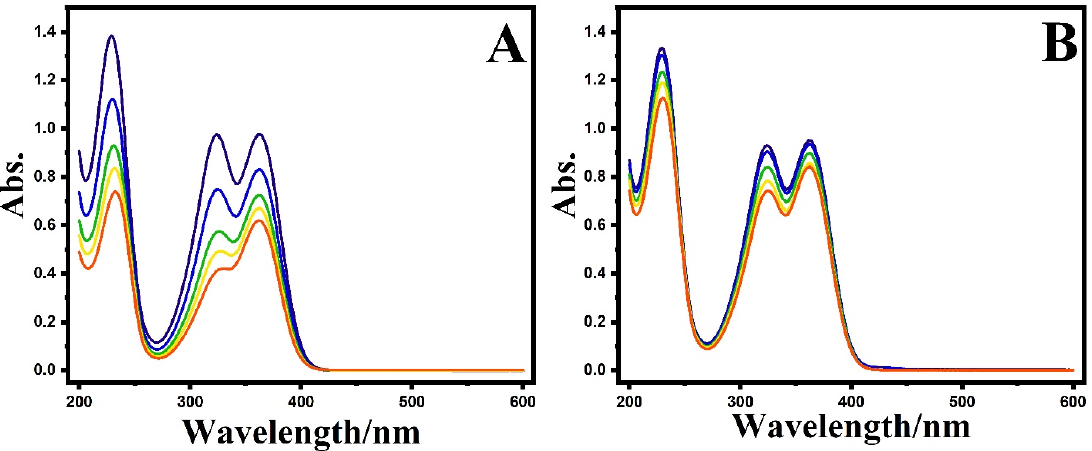
Figure 3. The spectrum of standard favipiravir (40.0 μ g mL ‐ 1 ) in the presence of 20.0 mg of ( A ) MIP ‐ Co/Ni@MOF and ( B ) NIP ‐ Co/Ni@MOF and ( B ) Co/Ni@MOF.